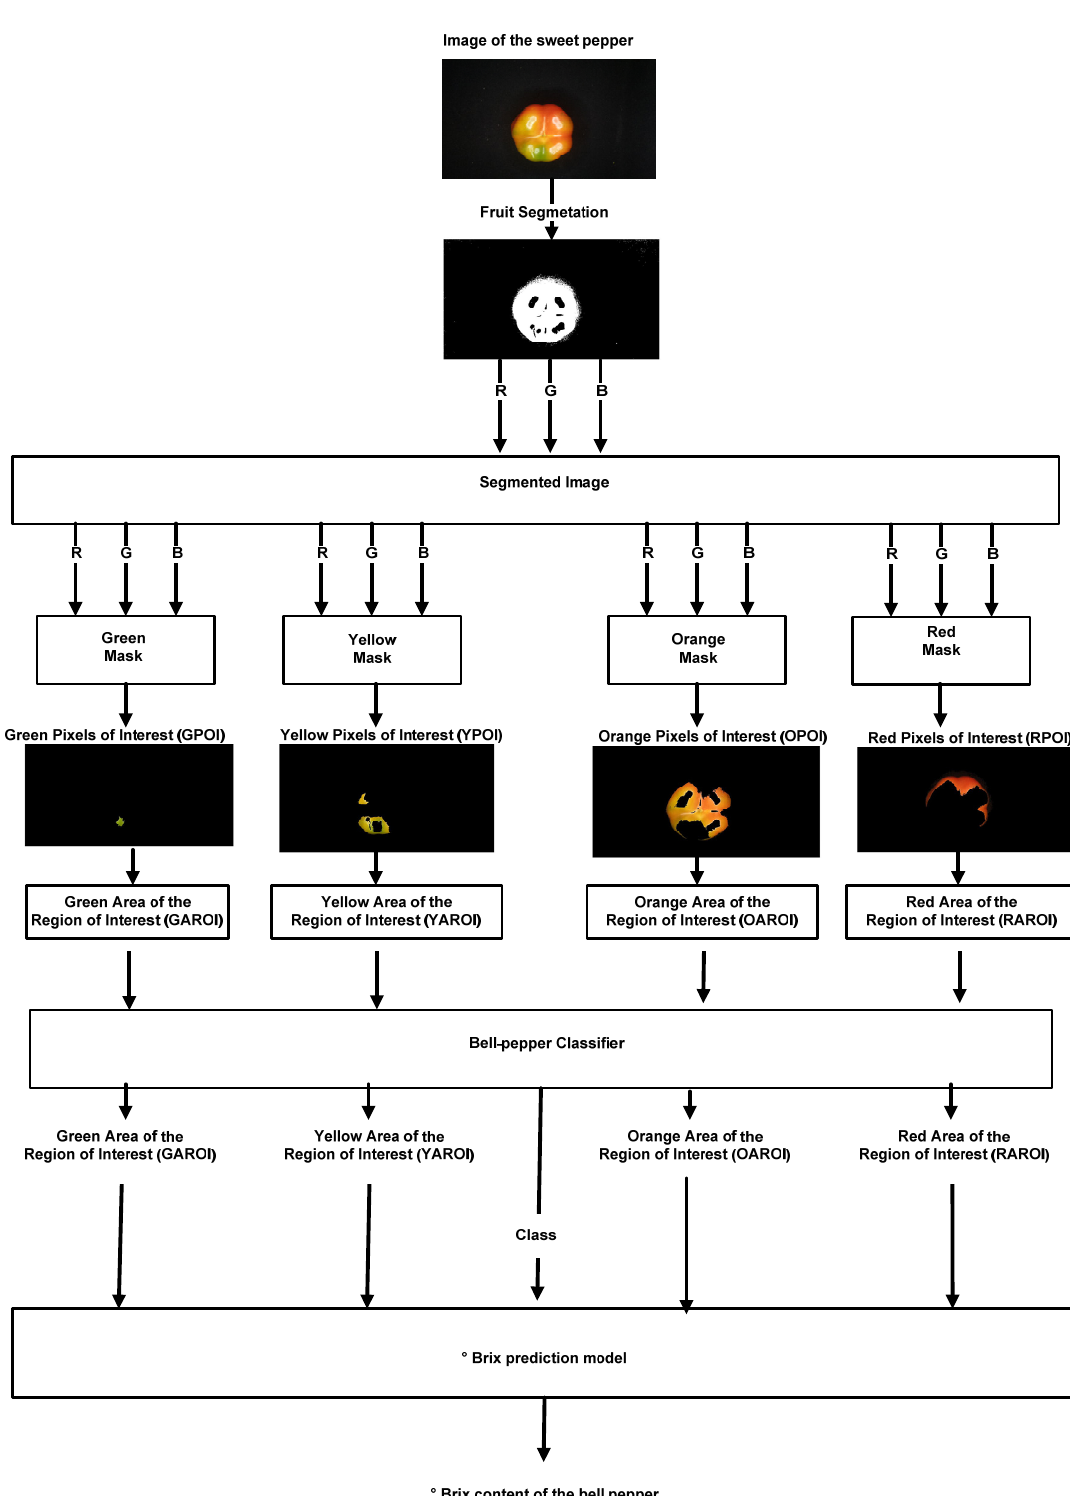
Figure 3. Proposed method to classify degrees of maturity in the bell pepper.